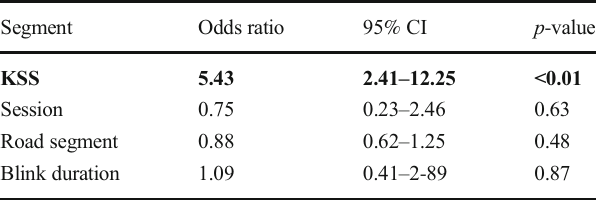
Logistic regression for line crossings – OR for KSS, Session (day/night), Road segment and blink